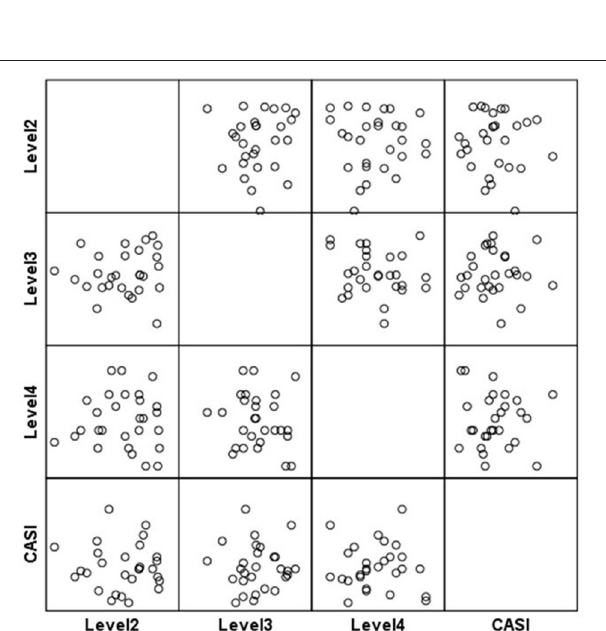
Higher game based problem-solving skills (Higher scores at Level 5) will be correlated with higher improvements in self-reported problem-solving (VAS).